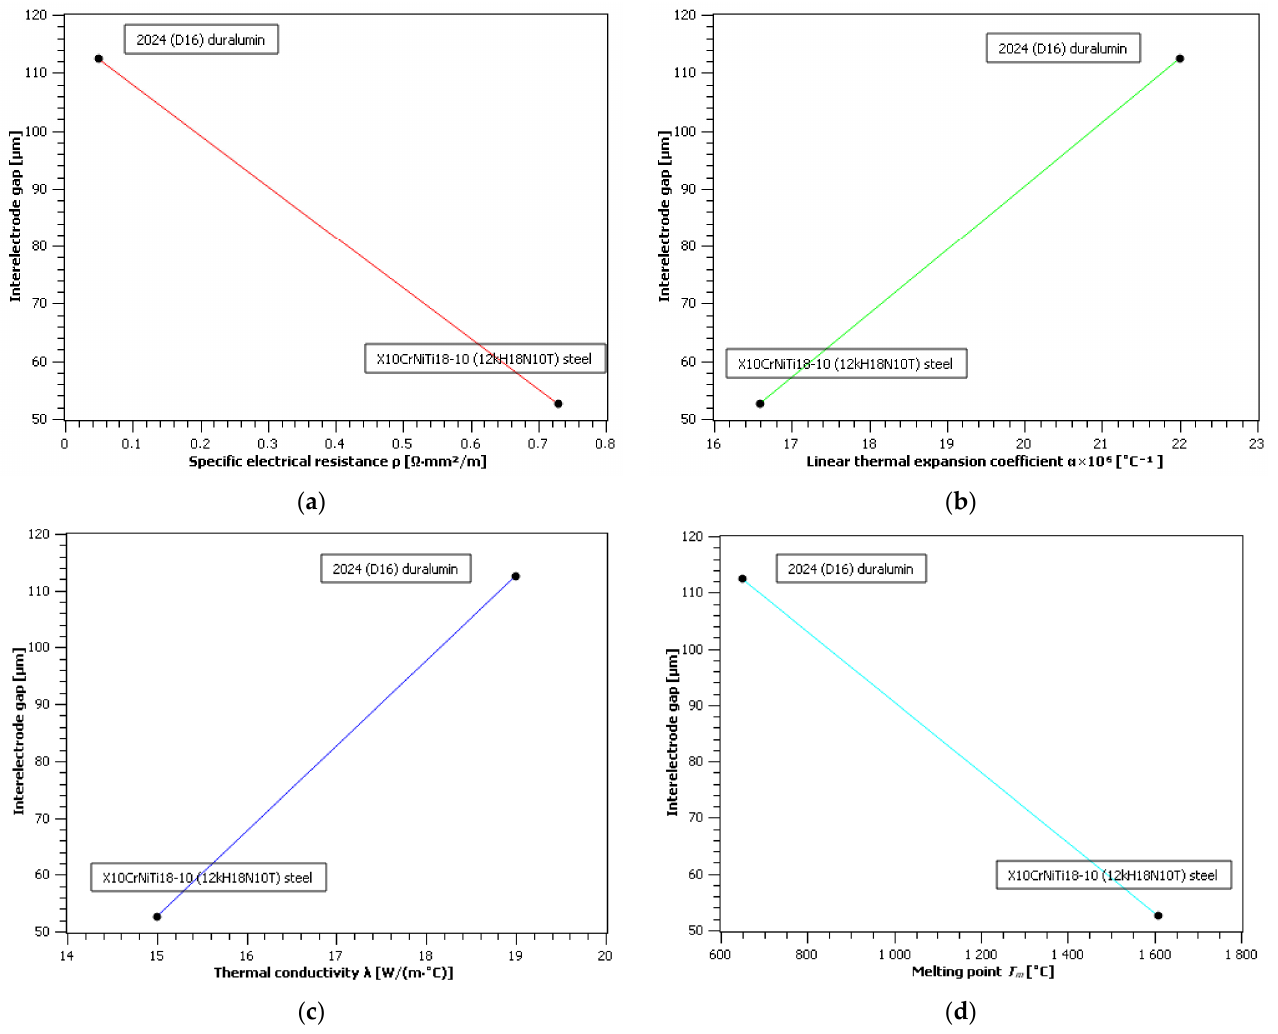
Figure 12. Dependencies of the interelectrode gap optimum values of X10CrNiTi18-10 (12kH18N10T) steel and 2024 (D16) duralumin after electrical discharge machining with a brass wire tool electrode in water medium on: ( a ) specific electrical resistance ρ . at +20 ◦ C, ; ( b ) linear thermal expansion coefficient α × 10 6 , ◦ C − 1 ; ( c ) thermal conductivity λ , W/(m · ◦ C); ( d ) sublimation/melting point T m , °C.